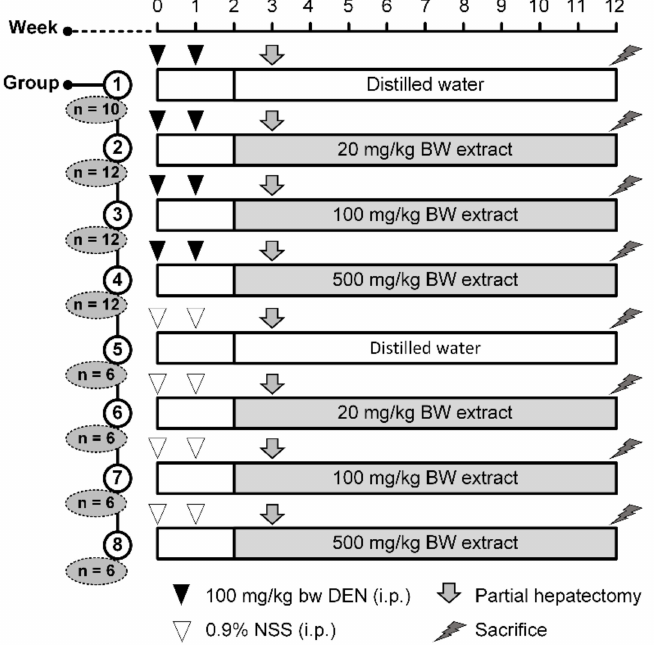
Figure 6. Experimental design to determine the chemopreventive property of CP in DEN-induced rats. BW: body weight; DEN: diethylnitrosamine; NSS: normal saline